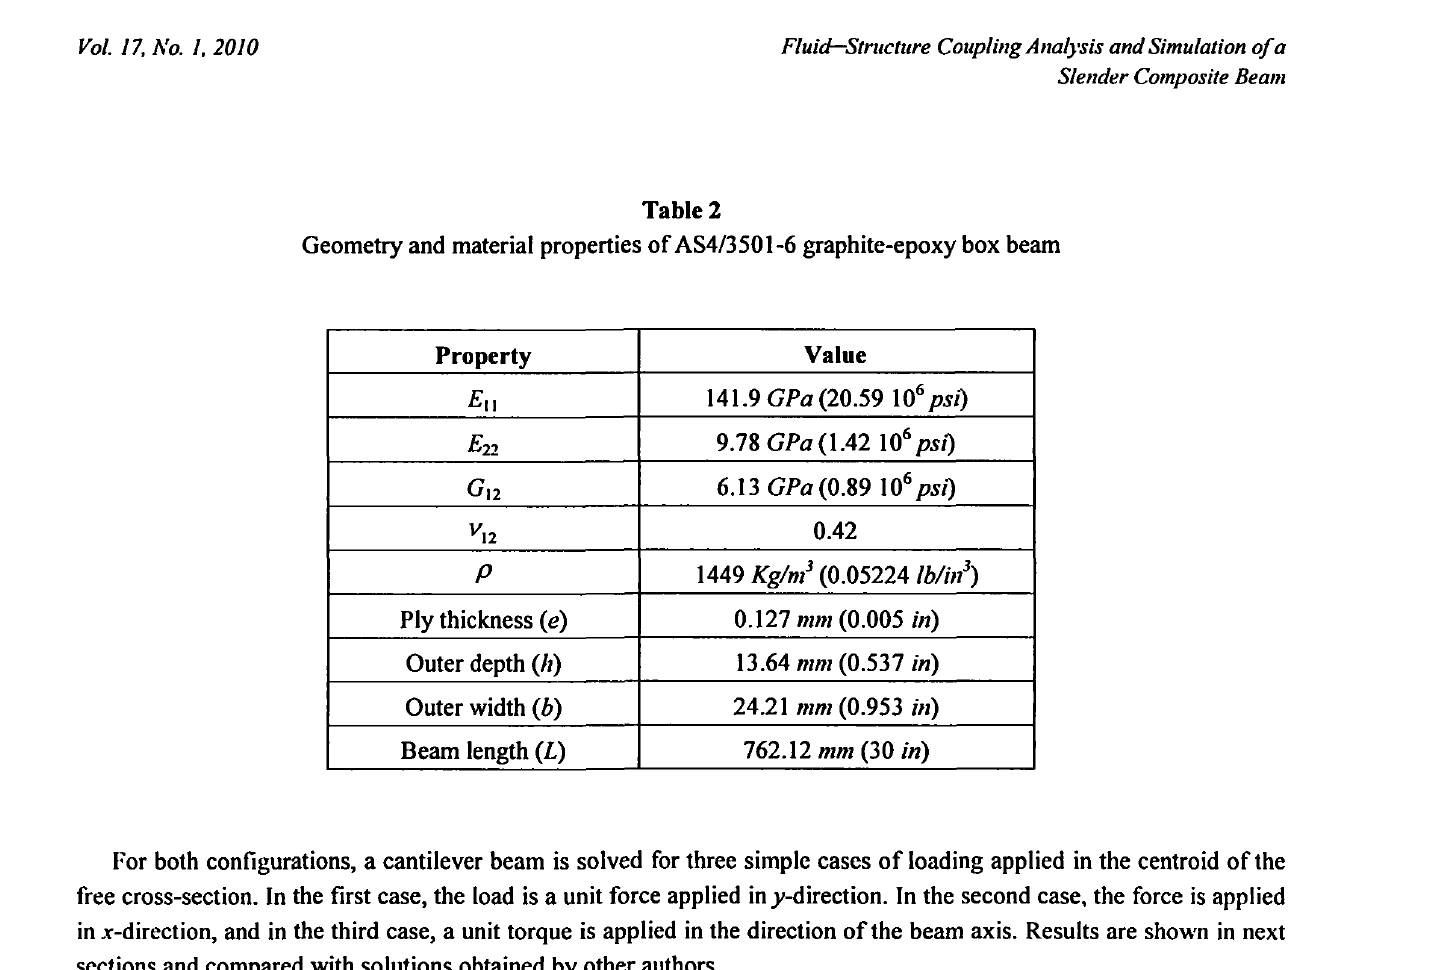
Geometry and material properties of AS4/3501-6 graphite-epoxy box beam